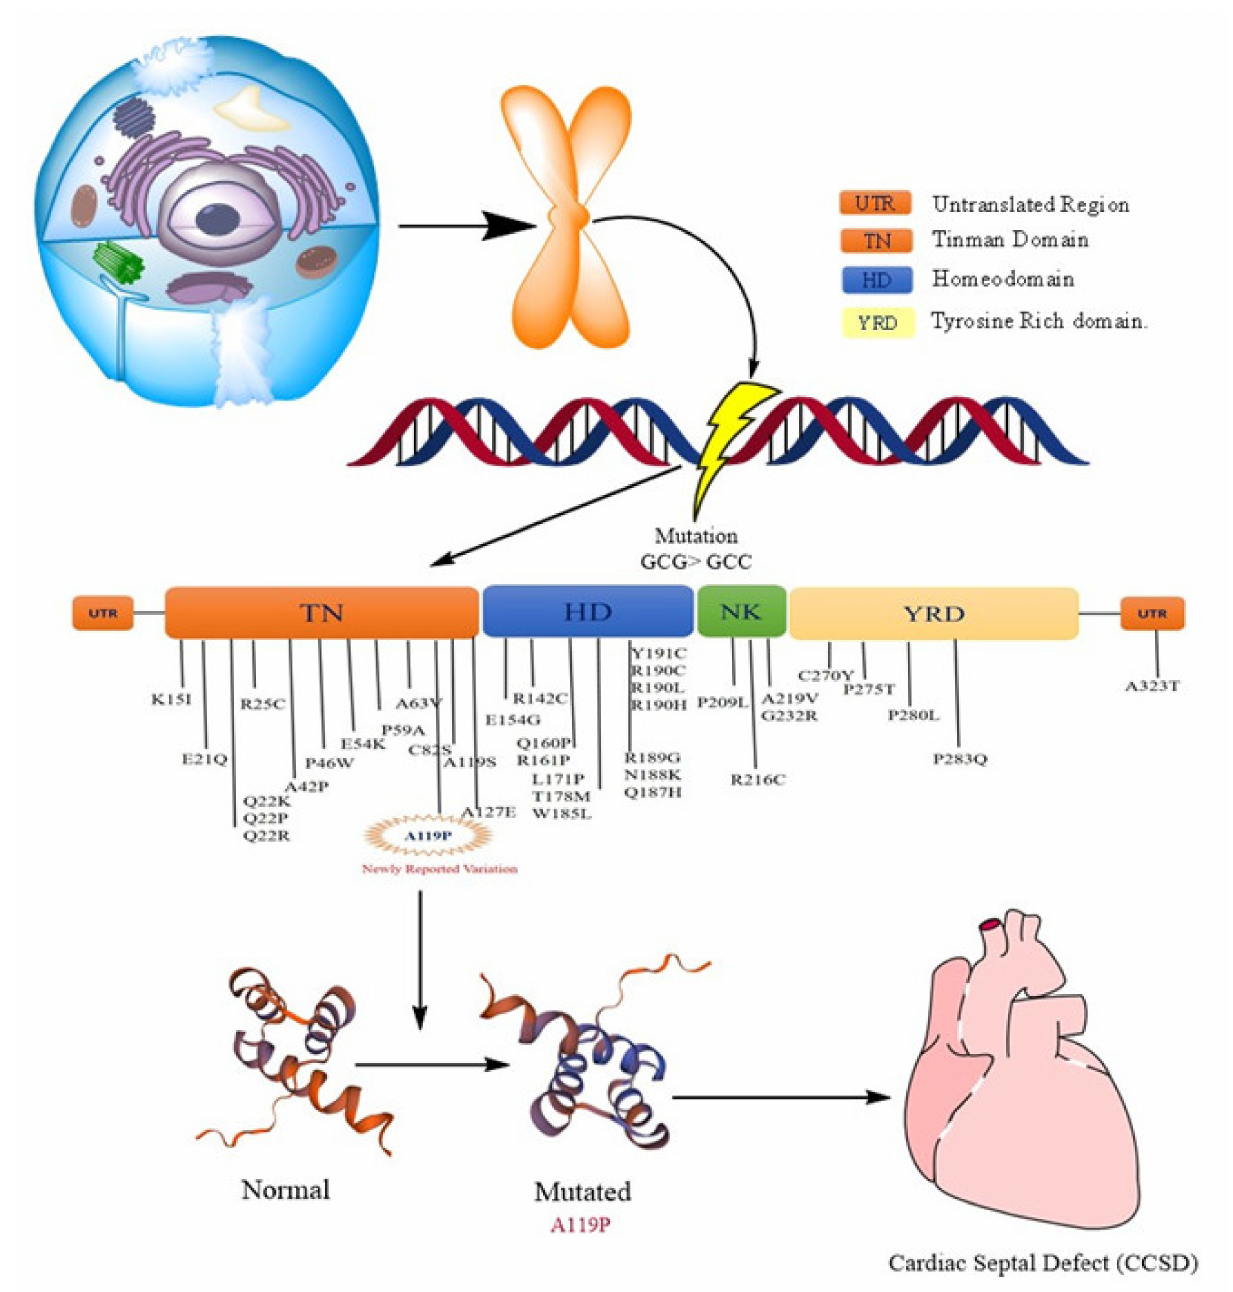
Figure 6. Schematic representation of the effect of the newly identified variant of NKX2-5 and its effect on